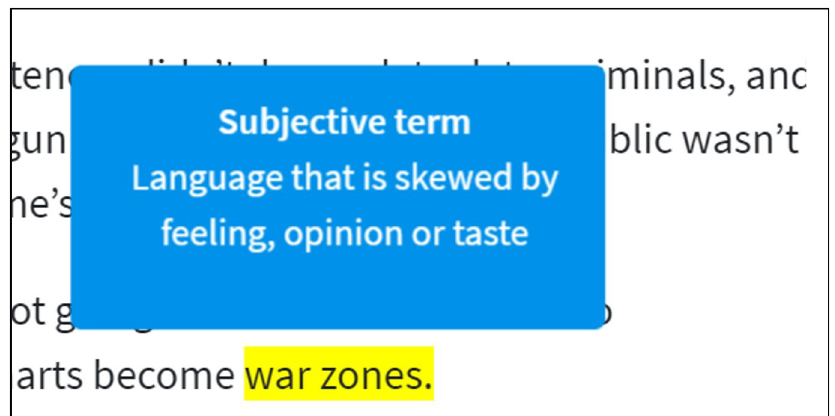
Fig 1. Annotation visualization. Example of the bias annotation "subjective term". Boxed annotation appeared by moving the cursor/finger over the highlighted text section.